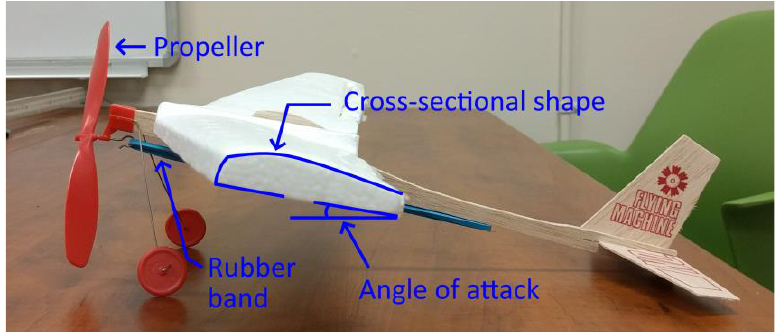
Fig. 1. An example of a rubber band airplane as an aerospace engineering